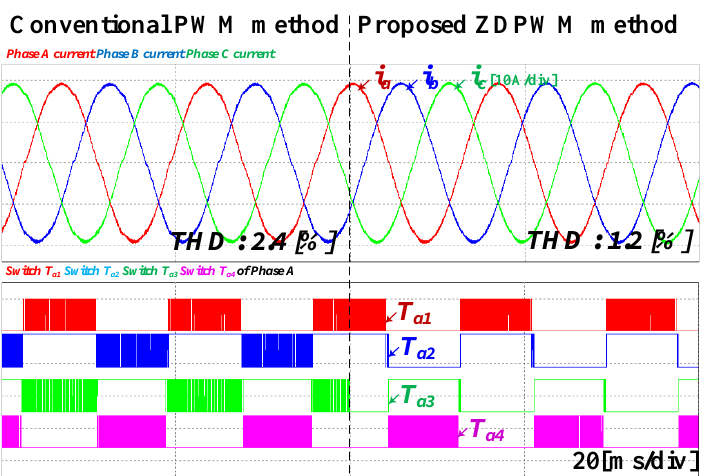
Figure 21. Simulation results of the conventional SVPWM method and proposed ZDPWM method with delay compensation applied in three-level NPC VSI (20 ms/div).